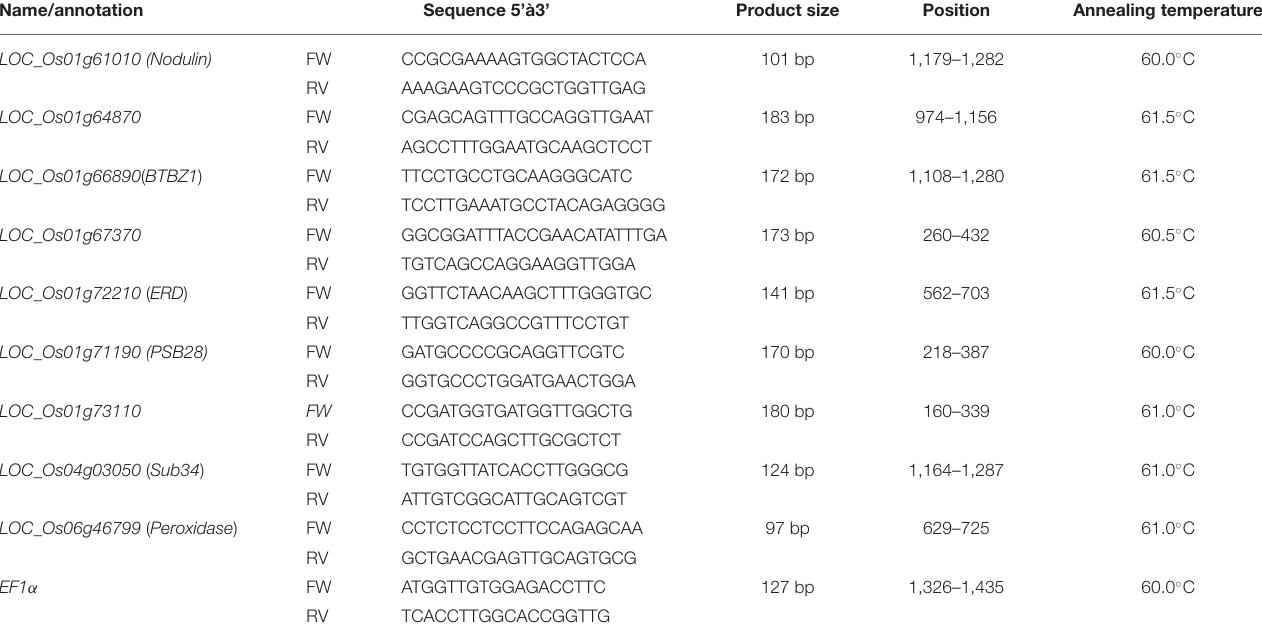
TABLE 1 | Quantitative RT-PCR rice